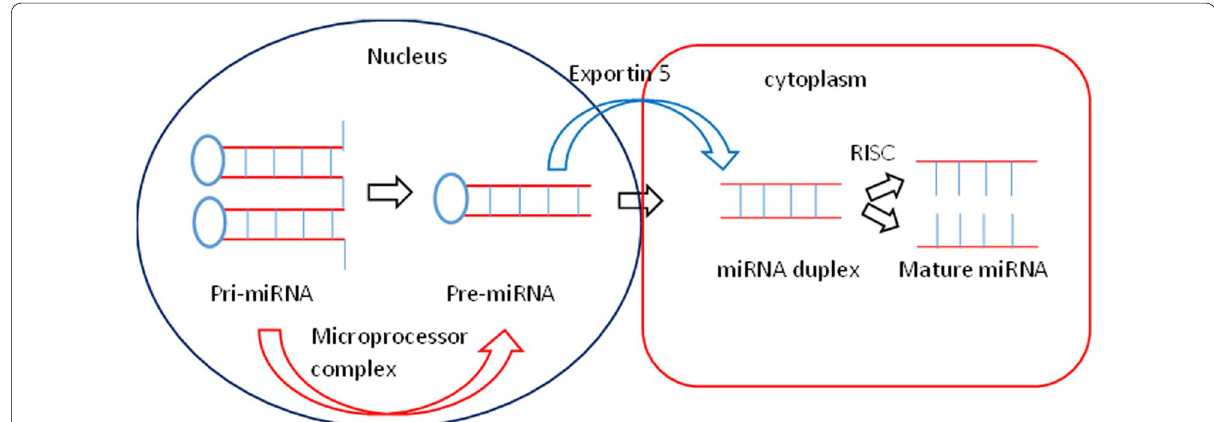
Fig. 1 With the help of a microprocessor complex in the nucleus, pri-miRNA is transformed to pre-miRNA. After that, pre-miRNA is transferred to the cytoplasm by exportin 5 and miRNA duplex formation occurs. Then, using RISC assembly, the miRNA duplex was transformed into mature